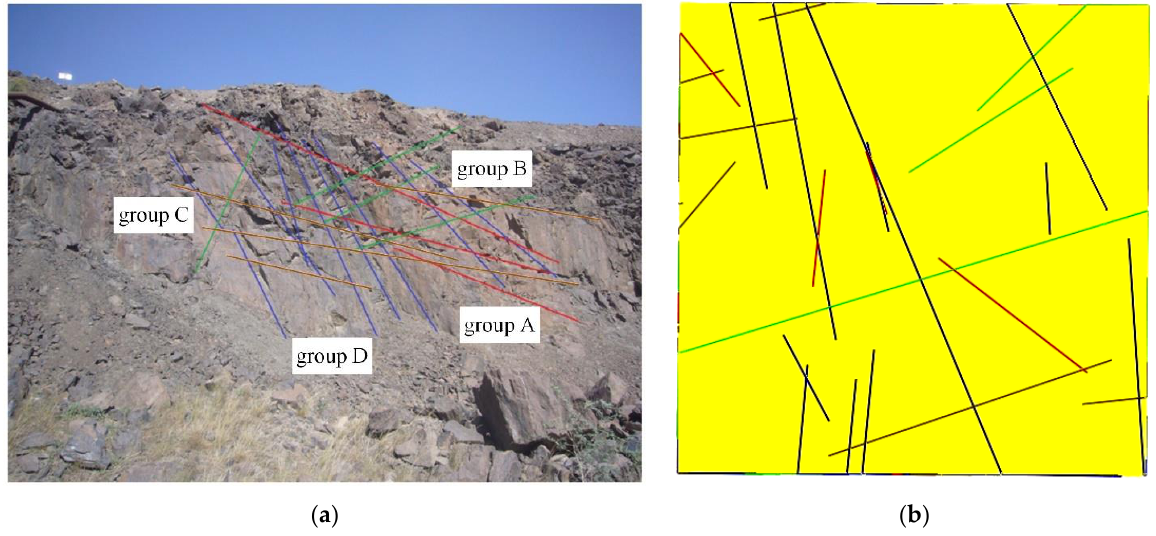
Figure 5. Comparison of images of fractures between the DFN simulation and the measurements on site. ( a ) Measured distribution of fractures on the outcropping surface; ( b ) distribution of fractures obtained by the DFN model on the boundary of the study domain.